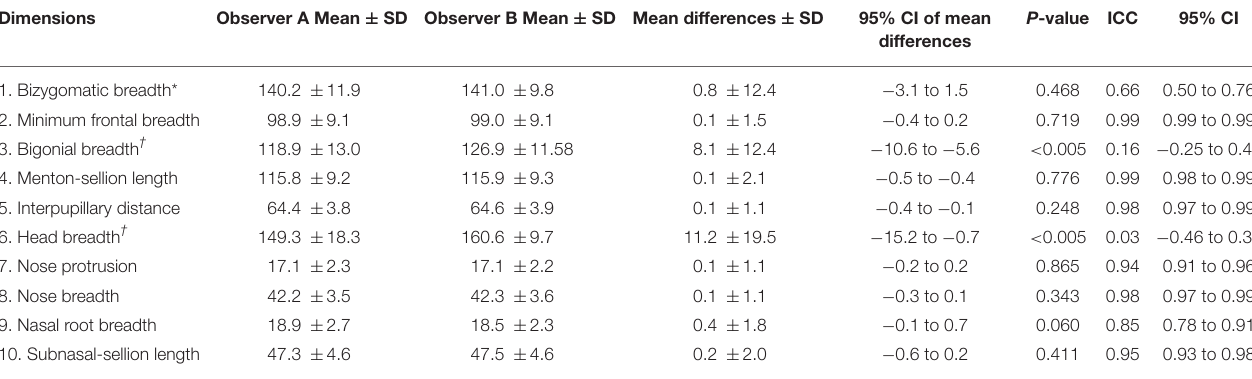
TABLE 2 | Summary of anthropometric statistics between observers of the 2D photogrammetry and inter-rater reliability coefficient of 2D photogrammetry.